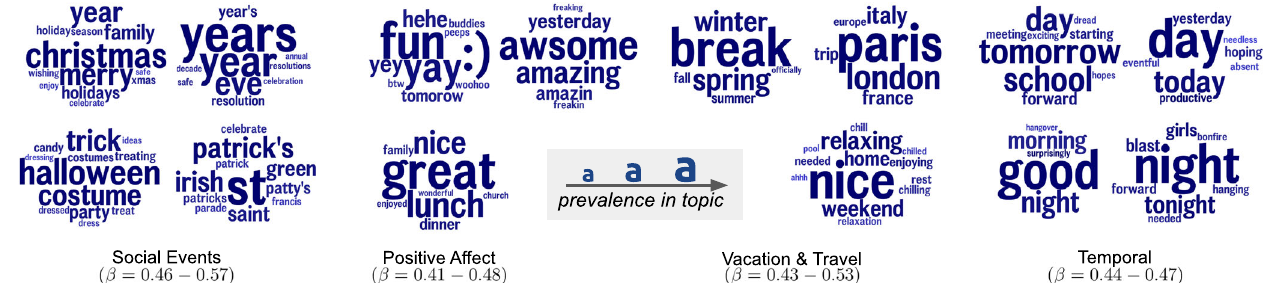
Fig. 5 Language associated with lower opioid death rates. Topics longitudinally predictive of lower opioid death rates: yearly change in language (2014 – 2015, 2015 – 2016) negatively associated with future year change in opioid death rates. Individual topics (clusters of semantically related words) are represented by their 15 most prevalent words (larger is more prevalent). Association ( β ) is the coef fi cient from standardized multiple linear models, adjusting for prior change ( p < 0.05; Benjamini – Hochberg adjusted for false discovery rate).